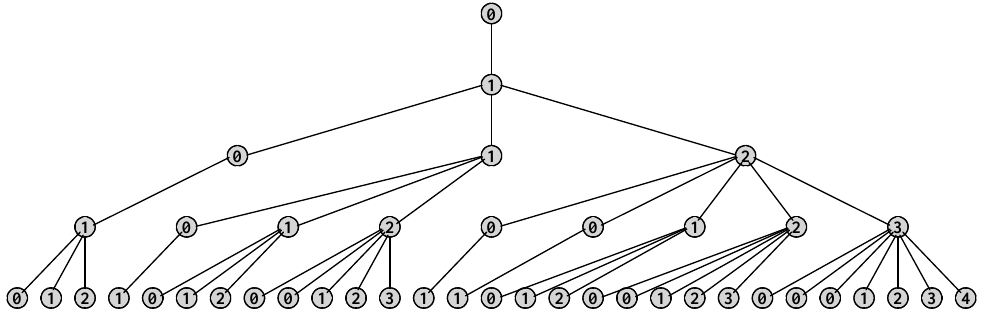
Fig. 4: The partial generating tree for the specification (11).